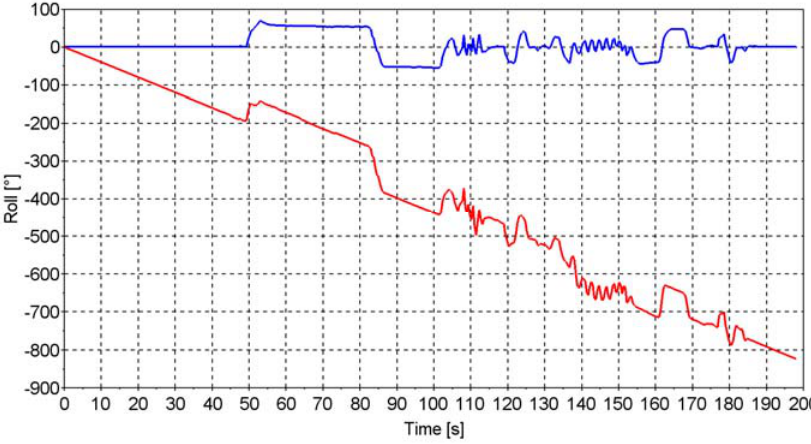
Figure 3. Integrated raw gyroscope data in red and Kalman filter output in blue during example orientation changes of the smart tag roll. We can observe a large drift in integrated gyroscope data while the filter output shows no drift.